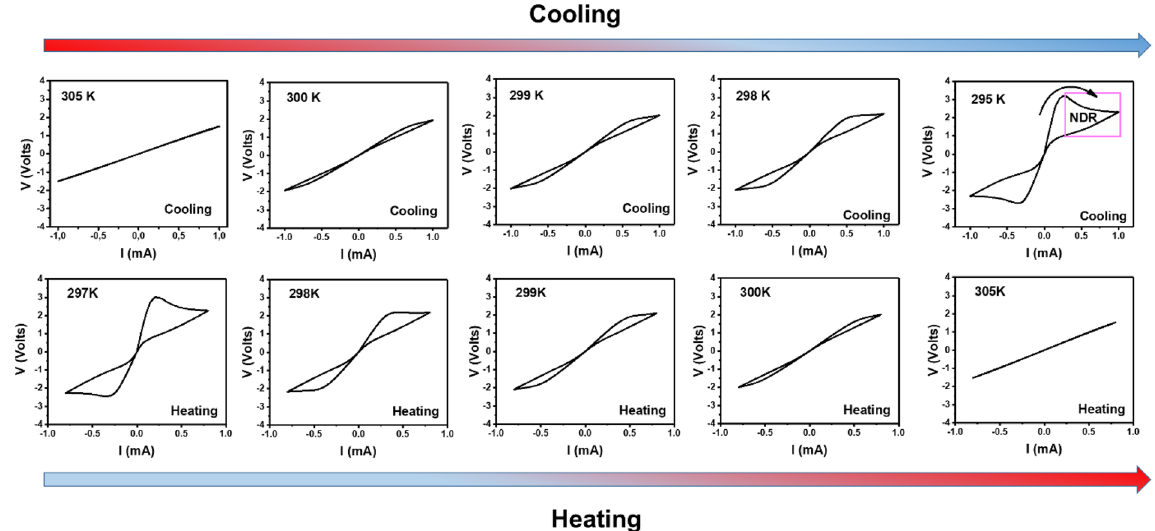
Figure 3. Voltage vs. current V(I) characteristics recorded at different temperatures while cooling from high temperature (top panels) or heating from low temperature (bottom panels).